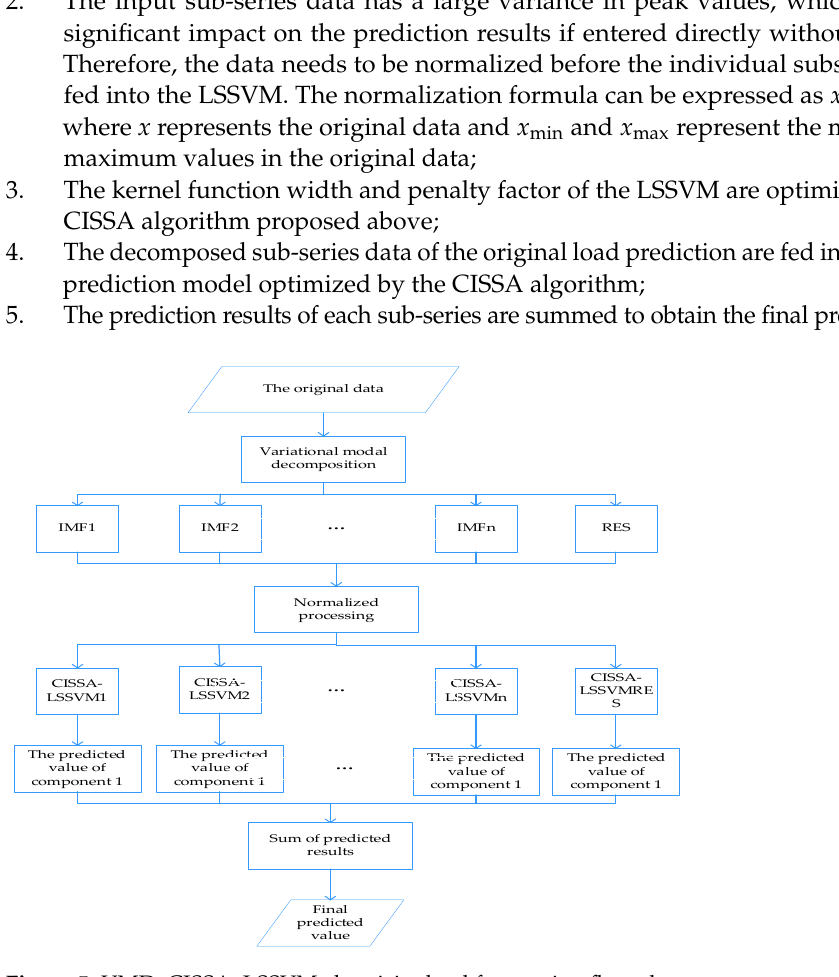
Figure 5. VMD–CISSA–LSSVM electricity load forecasting flow chart.